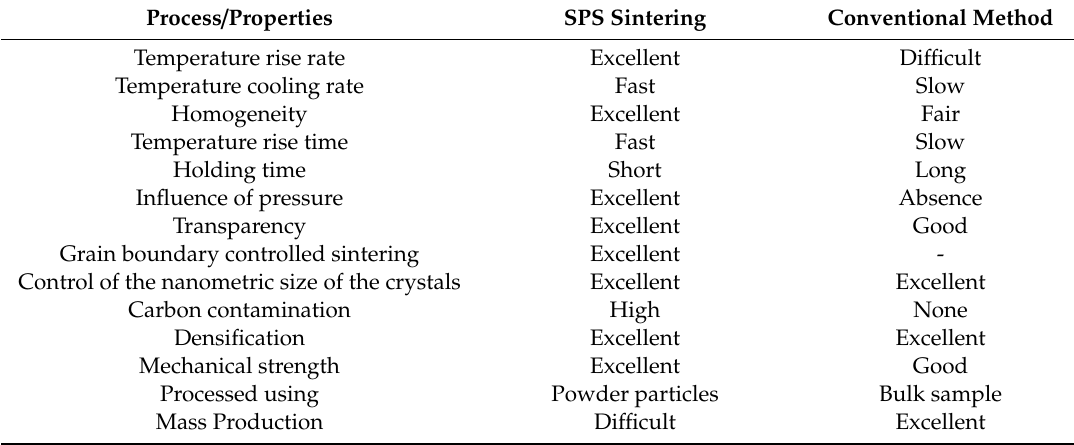
Table 2. Comparison of characteristics on spark plasma sintering (SPS) vs. conventional method for the preparation of transparent